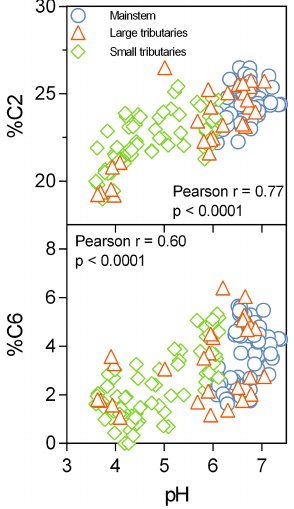
Figure 8. Relationship between the relative contribution of aliphatic components (C2 and C6) and pH of stream waters in the Congo Basin.